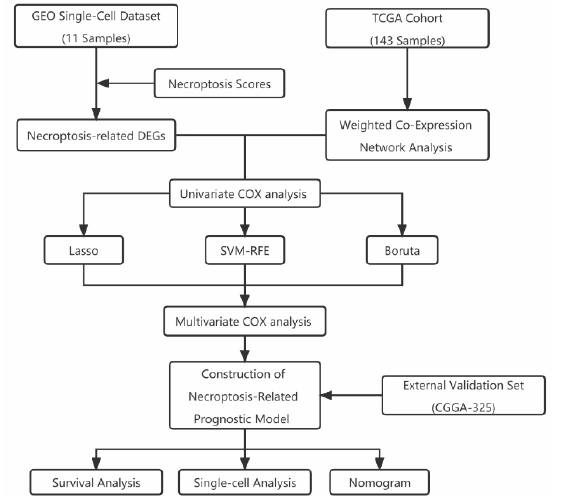
Figure 1. Flow chart.